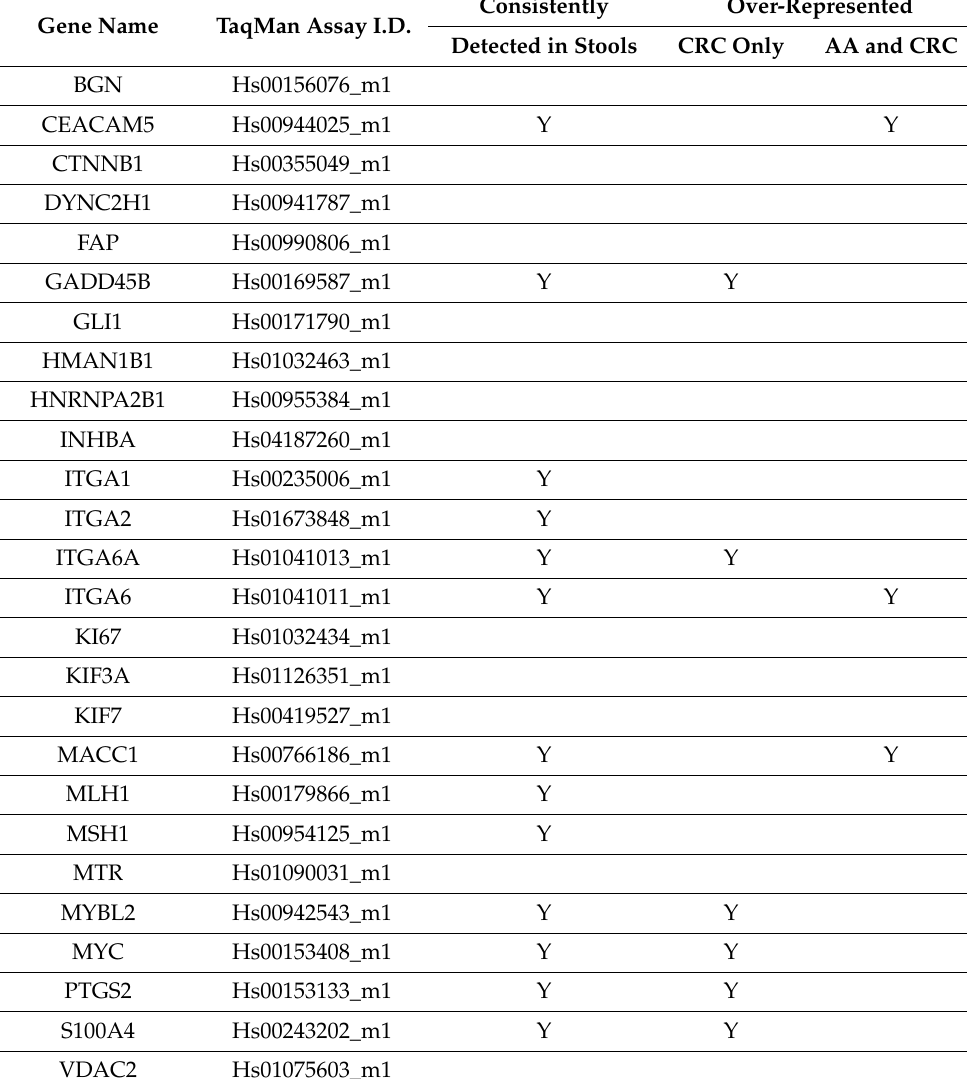
Table 1. List of specific targets